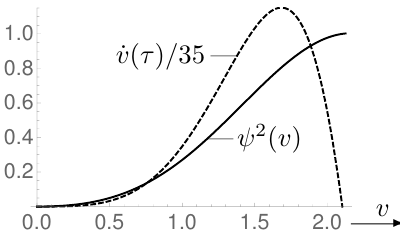
Figure 2. QR-solution of the WdW-equation Equation (14) to the square, and velocity ˙ v ( τ ) from Equation (16) (divided by 35 for combinability with ψ 2 ) for the VL-type “soft entry”.